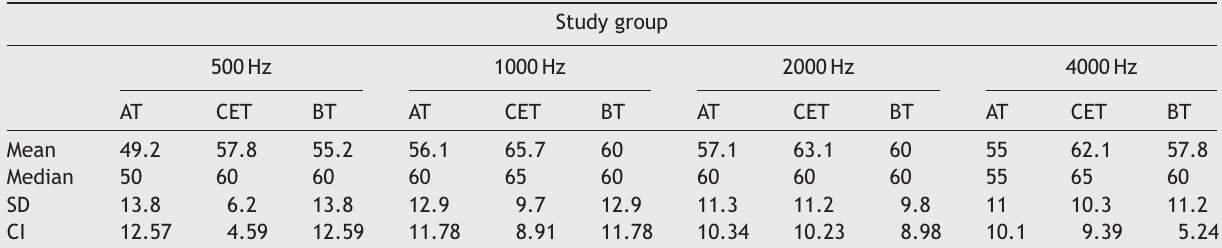
Descriptive measures of auditory, electrophysiological, and behavioral thresholds for the study group by frequency. Study group